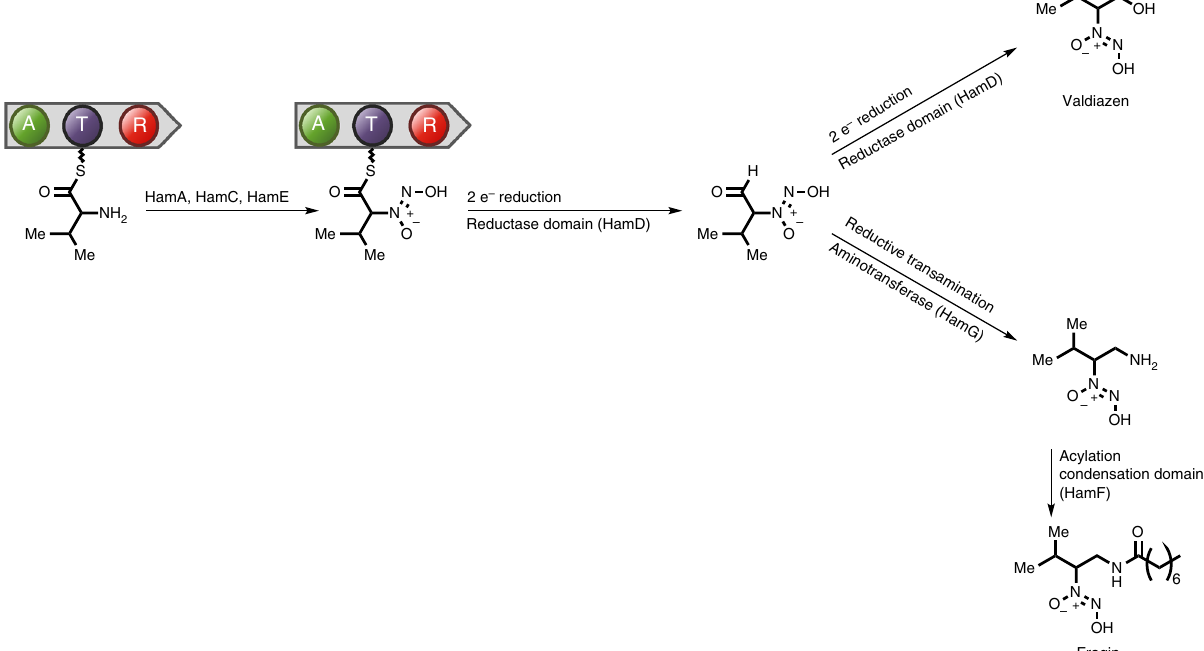
Fig. 6 Proposed model of fragin and valdiazen biosynthesis. The amino group of L -valine, which is bound to HamD, is transformed into a diazeniumdiolate group by the tailoring enzymes HamA, HamC, and HamE. The resulting intermediate molecule is then released in a two-step process. The fi rst 2-electron reduction step catalyzed by the HamC R-domain results in an aldehyde intermediate, which can undergo a second 2-electron reduction to yield valdiazen. Alternatively, the aldehyde intermediate can be transaminated by HamG, resulting in an amino derivative, which can be acylated by HamF to yield fragin. A: adenylation domain, T thiolation domain, R reductase domain; e −